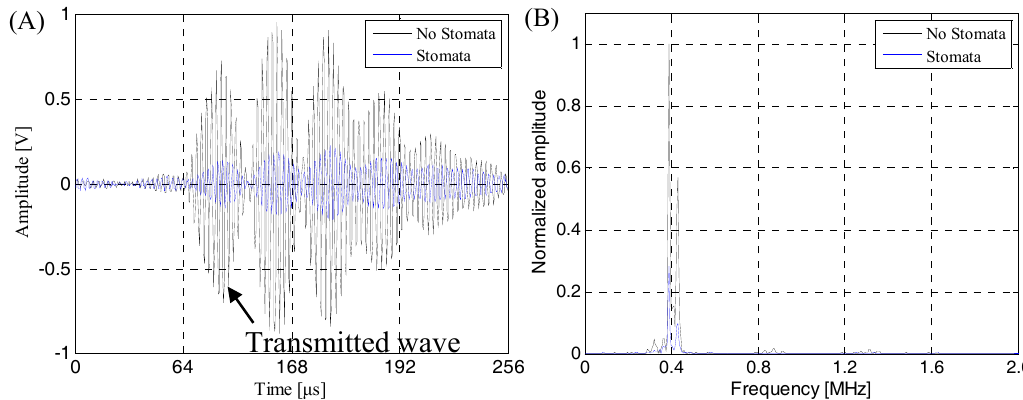
Figure 21. The contrast between the transmission signal of a natural stomata defect inside a lithium-ion battery and the transmission signal of an intact lithium-ion battery sample. ( A ) The transmission signal; ( B ) The corresponding frequency spectrum.